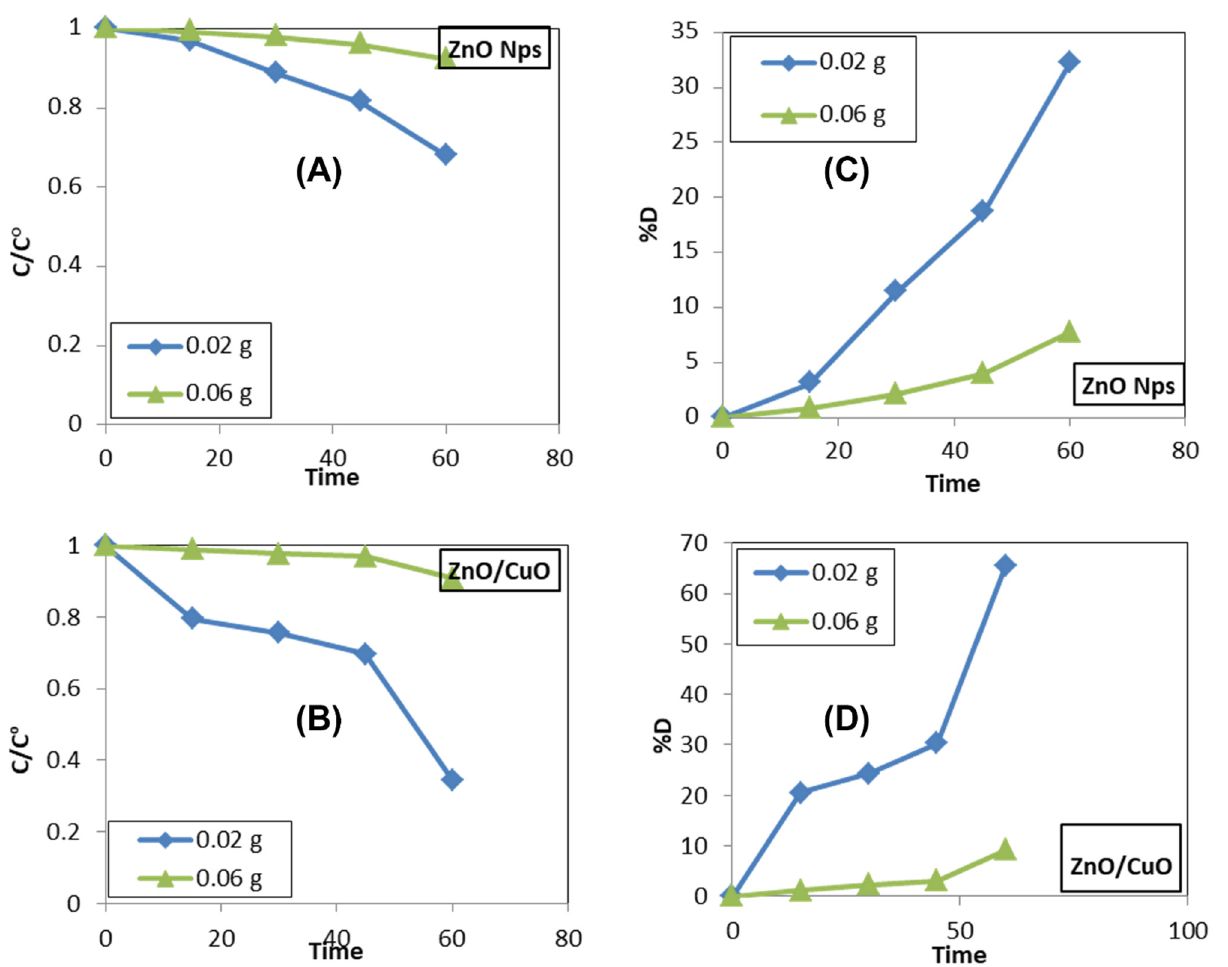
Figure 7. ( A , B ) C/Co of ZnO Nps and ZnO/CuO nanocomposite at 0.02 g and 0.06 g, and ( C , D ) % degradation of ZnO Nps and ZnO/CuO nanocomposite at 0.02 g and 0.06 g,